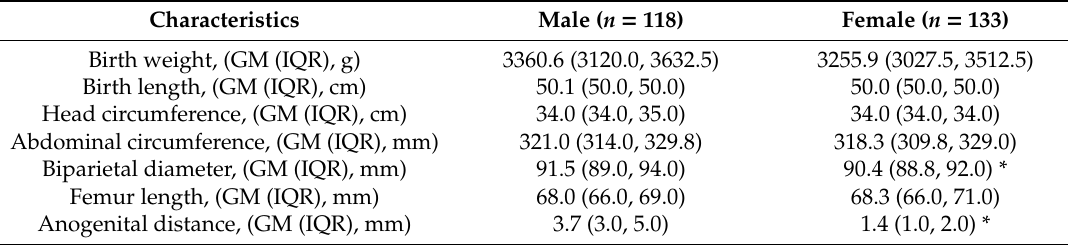
Table 2. Characteristics of the newborns ( n =